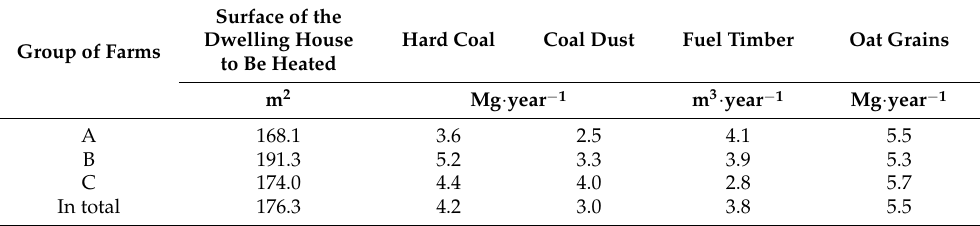
Table 9. Utilization of energy carriers in surveyed farms for heating purposes [75]. Surface of the Dwelling House Hard Group of Farms to Be Heated